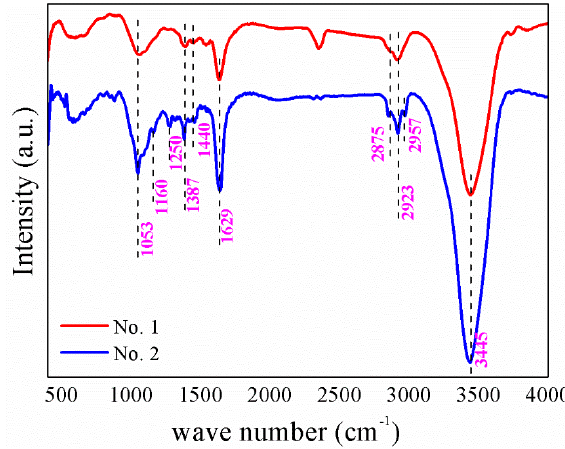
Figure 7. Typical FT-IR spectra of ( a ) Sample No. 1 and ( b ) Sample No. 2.